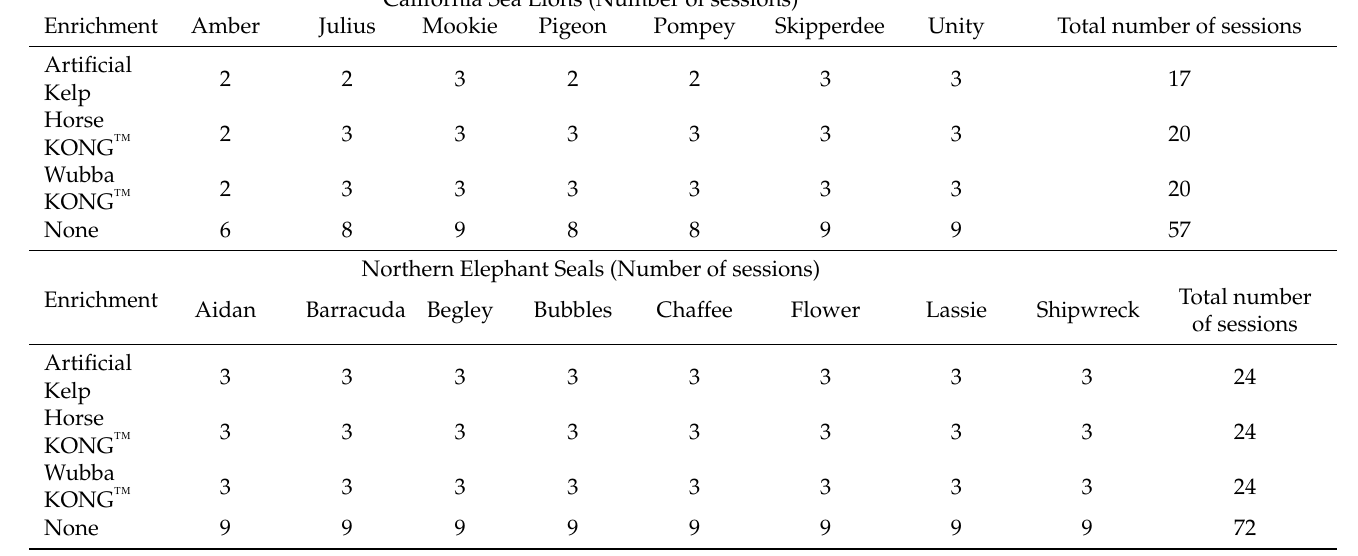
Table 3. Number of sessions per patient in the study and enrichment device. California Sea Lions (Number of